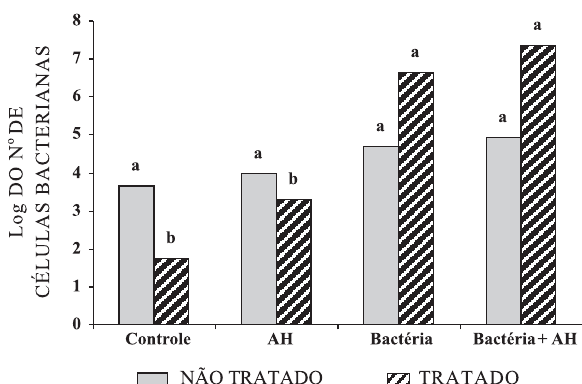
Figura 3. Nível populacional de Herbaspirilum seropedicae estirpe HRC 54 em raízes frescas de microtoletes (log do número de células bacterianas por grama de tecido fresco) de cana- de-açúcar cv RB 72-454 tratados termicamente com água a 50,5 °C por duas horas (tratado) ou não (não tratado) e submetidos à imersão por 12 h numa solução que continha: água (controle), ácidos húmicos (AH) na concentração de 20 mg L -1 de C , Herbaspirilum seropedicae AH estirpe HRC 54 na concentração de 10 8 mL -1 de células em água (Bac) e pelo uso em conjunto de AH e bac (Bactéria + AH). Médias seguidas por letras diferentes são estatisticamente diferentes pelo teste Tukey (p <